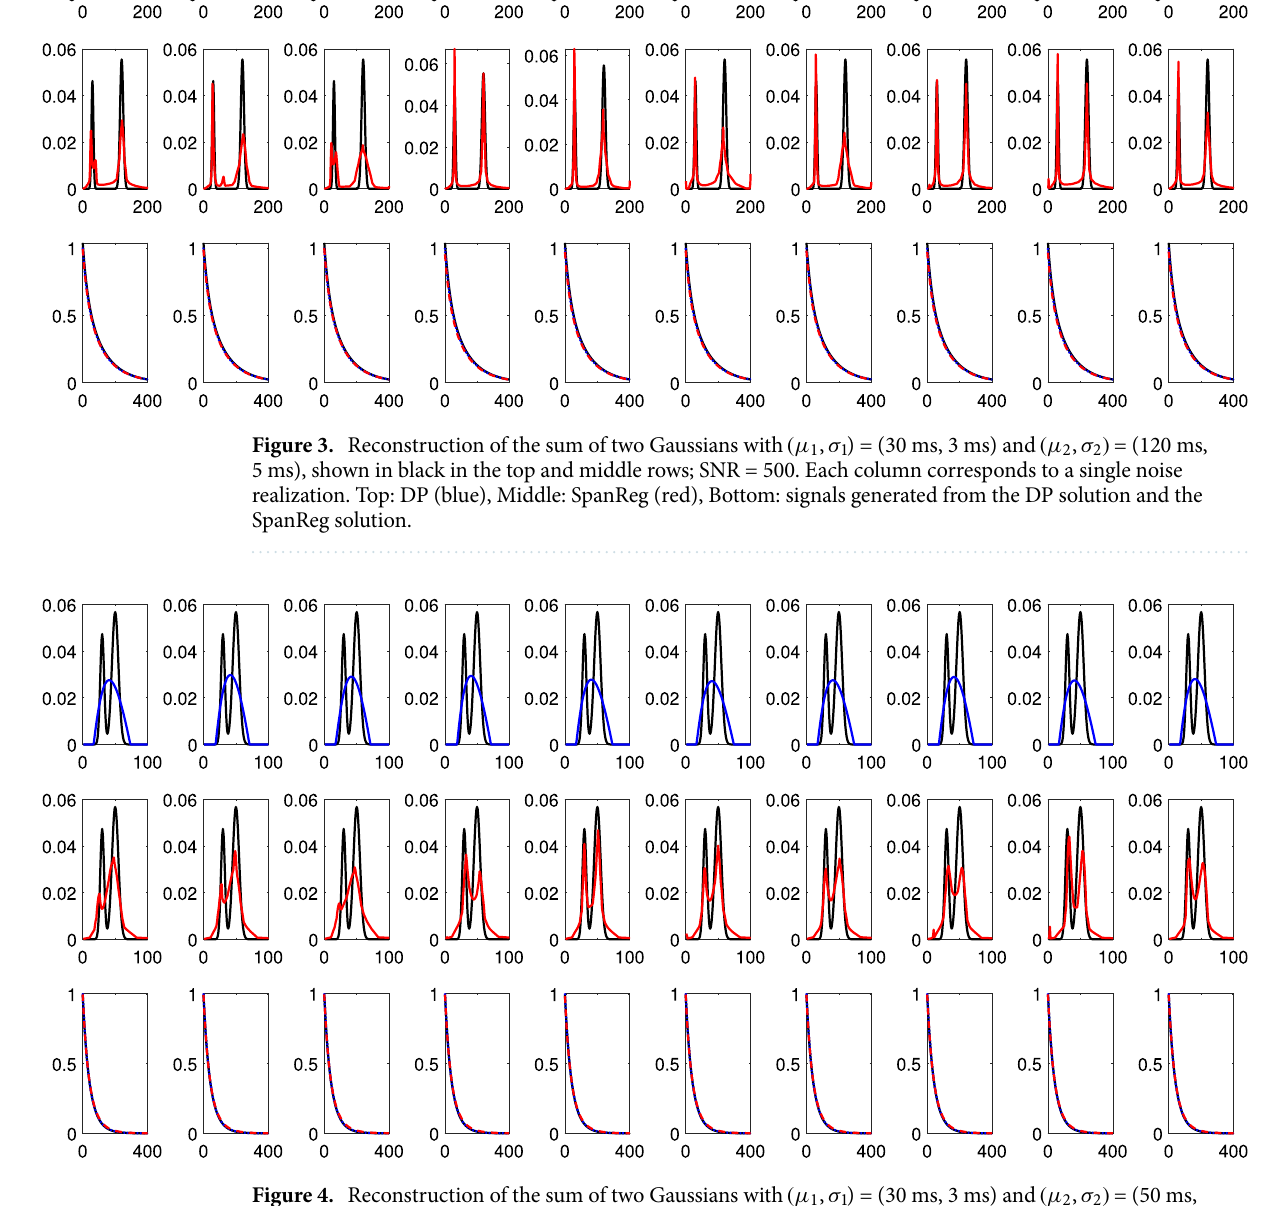
Figure 4. Reconstruction of the sum of two Gaussians with (µ 1 , σ 1 ) = (30 ms, 3 ms) and (µ 2 , σ 2 ) = (50 ms, 5 ms), shown in black in the top and middle rows; SNR = 500. Each column corresponds to a single noise realization. Top: DP (blue), Middle: SpanReg (red), Bottom: signals generated from the DP solution and the SpanReg